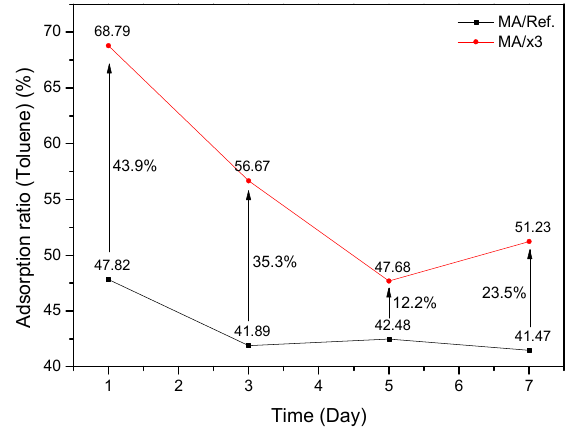
Figure 8. Adsorption ratio of toluene.